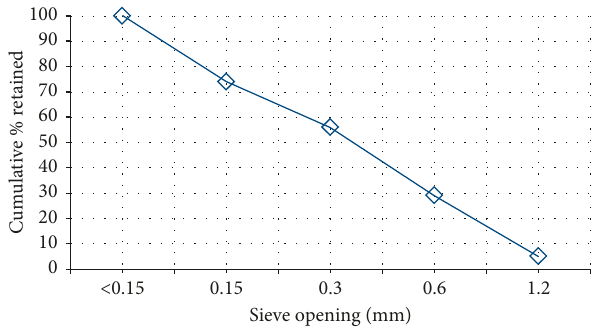
Figure 1: Fine aggregate particle size distribution. Table 1: Chemical composition of red ceramic and porcelain waste